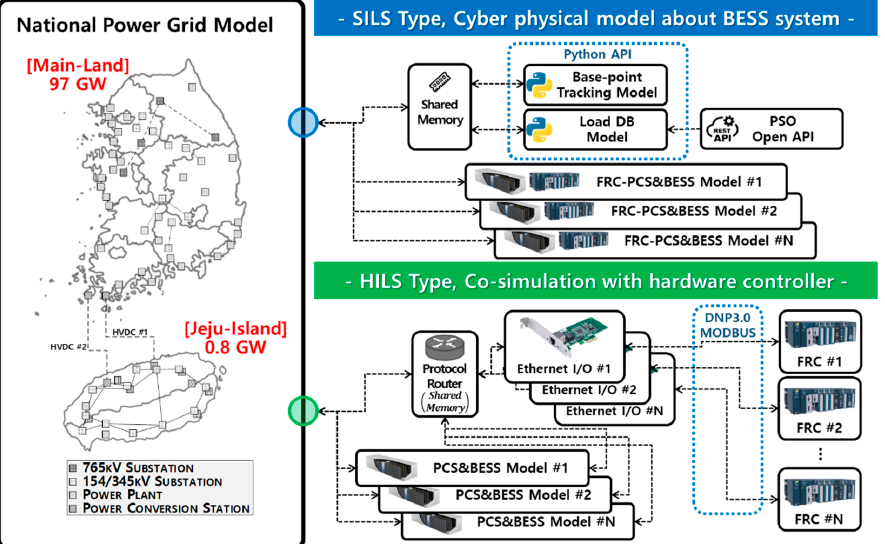
Figure 1. National power grid model and configuration of A1GridSim simulation modes.